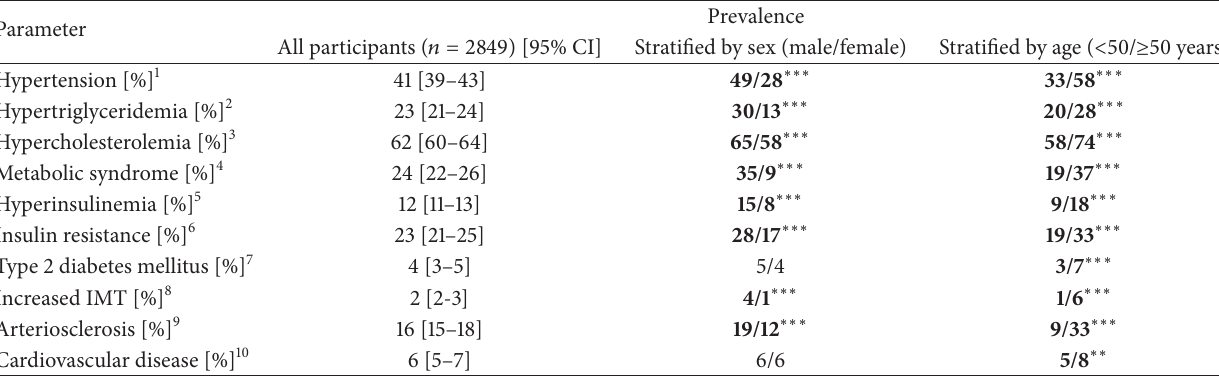
Figure 2: Cardiometabolic risk factors stratified by BMI. Shown are mean ± standard deviations for (a) systolic blood pressure, (b) diastolic blood pressure, (c) triglycerides, (d) total cholesterol, (e) LDL cholesterol, (f) HDL cholesterol, (g) HbA1c, and (h) intimamedia thickness stratified by BMI categories. Differences were determined by ANOVA test, log values for triglycerides ( ∗∗∗ 𝑃 < 0.001 ). Table 3: Prevalence of cardiometabolic